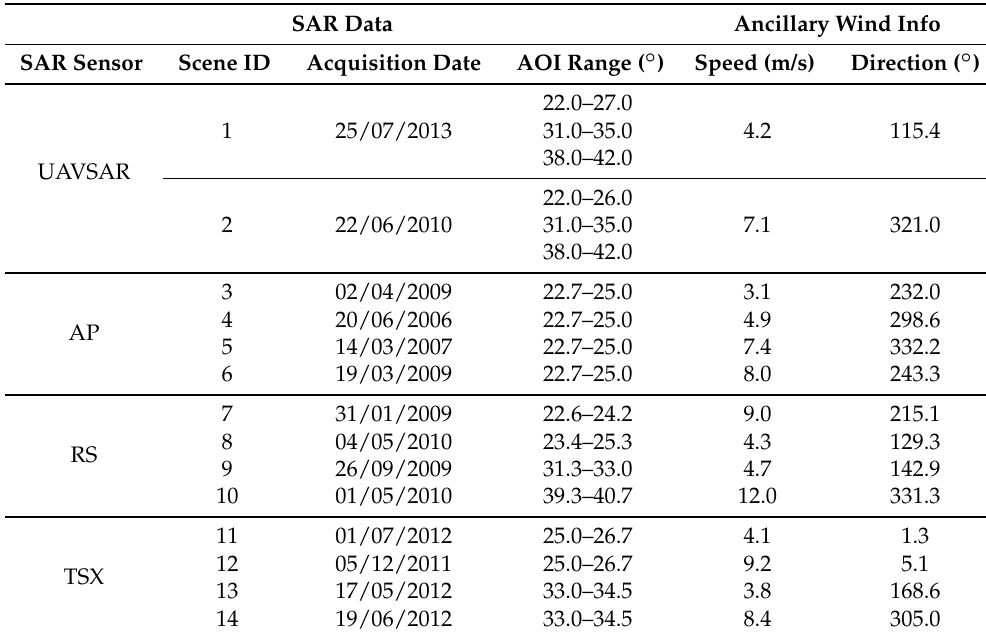
Table 2. Overview of the